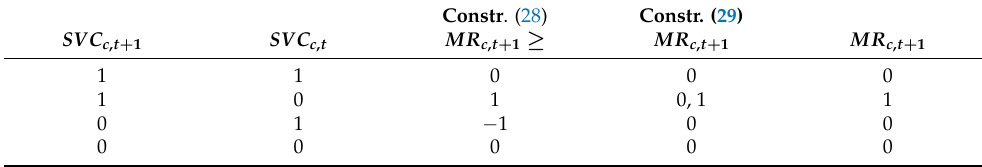
Table 3. Constraint (26)–(29)